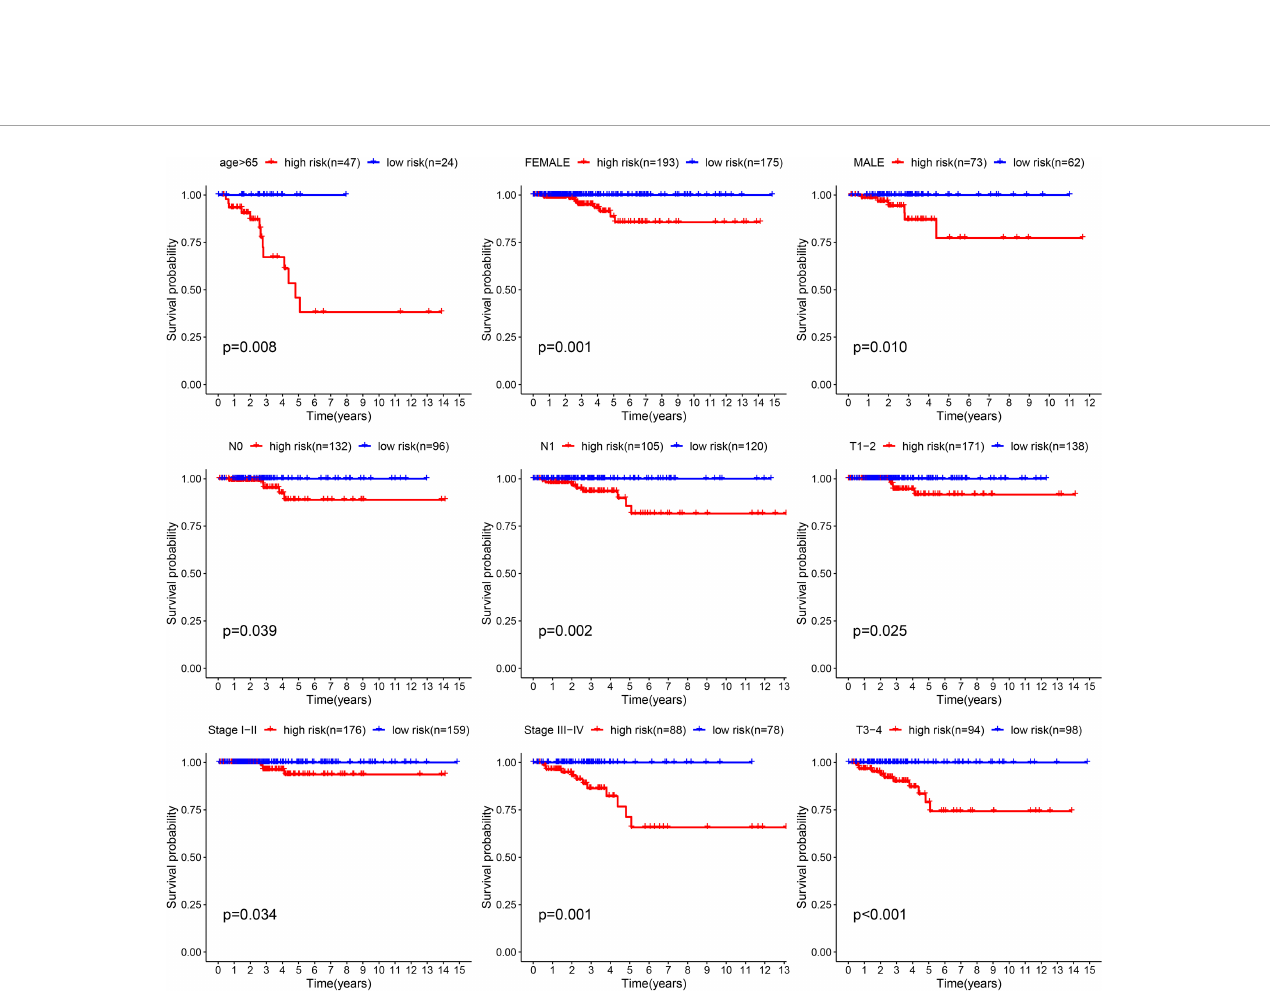
FIGURE 6 K-M survival analysis presenting the signi fi cance of prognosis between low- and high-risk THCA in subgroups of age > 65, female, male, N0, N1, T1 – 2, T3 – 4, clinical stage I – II, and clinical stage III –